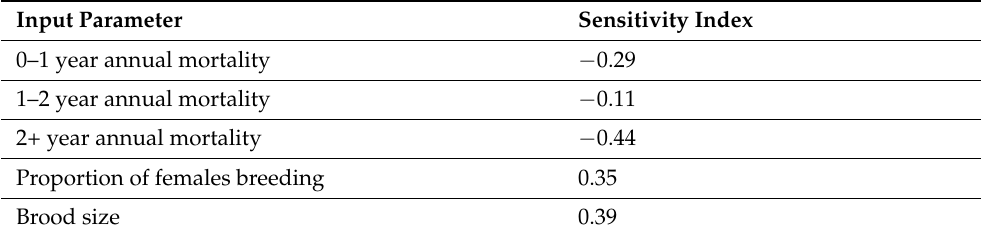
Table 3. Sensitivity analysis output. The relative sensitivity of PVAs to different input parameters based on perturbation